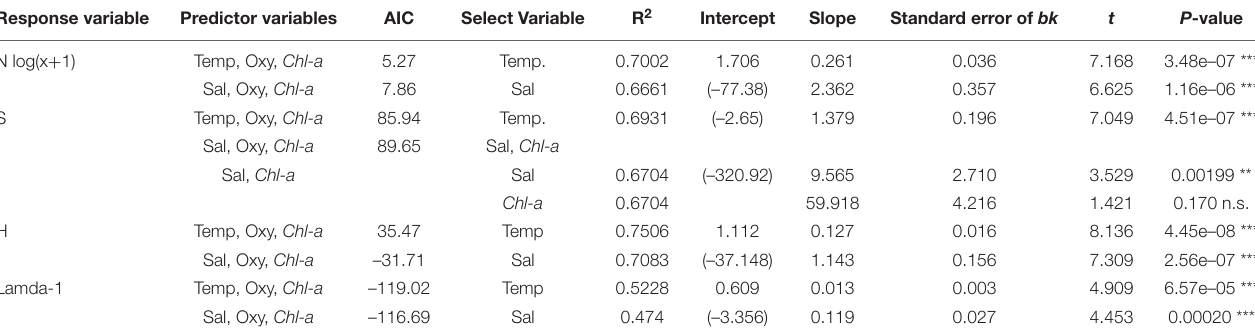
FIGURE 9 | The relationship between species richness (S), abundance (log N), and the Shannon-Wiener (H (cid:48) ) and Simpson ( λ (cid:48) ) indices of diversity of the copepod community in the SPSG during the austral spring of 2015 and environmental (bio-physical) drivers (temperature, salinity, oxygen, and Chl-a ). TABLE 4 | Multiple linear regression (stepwise) to assess the relation between community descriptors (N = abundance, S = Richness, H = Shannon-Wiener diversity index and Lamda-1 = Simpson diversity index) and environmental conditions. Response